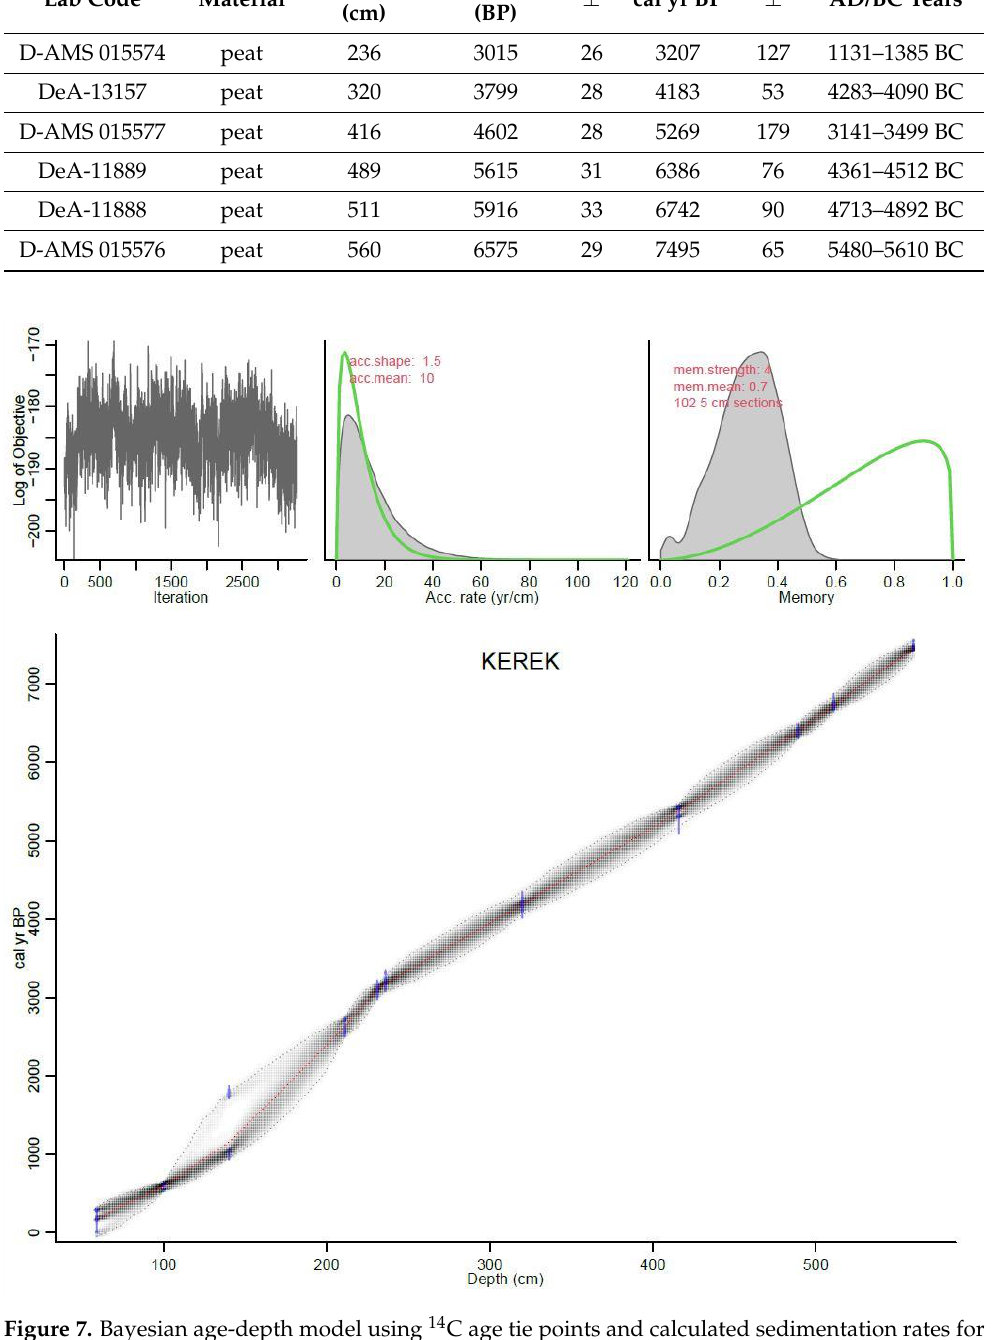
Figure 7. Bayesian age-depth model using 14 C age tie points and calculated sedimentation rates for sampled intervals using Bacon [60] for core Round Lake at Sânpaul, Romania. Top left: Markov Chain Monte Carlo model iterations. Top middle: prior (green line) and posterior (solid gray) distribution of accumulation rate. Top right: prior (heavy green line) and posterior (solid gray) distribution of the model memory. Bottom, calibrated 14C dates in blue and the age–depth model. Grey stippled lines show 95% confidence intervals. The central dotted red curve is the ‘best’ model based on the weighted mean age.